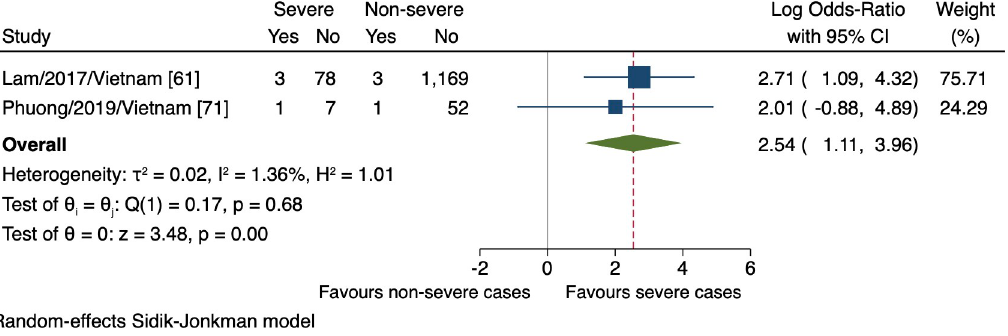
Fig 6. Forest plot showing the relationship between hepatomegaly ( > 2 cm) and severe dengue. The red dashed line represented the overall effect size.